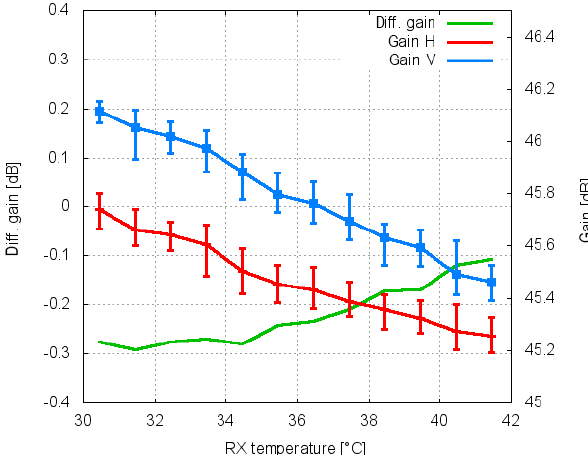
Figure 15. Bin-wise-averaged gain (H and V; see Fig. 14) and com- puted as g H − g V versus receiver